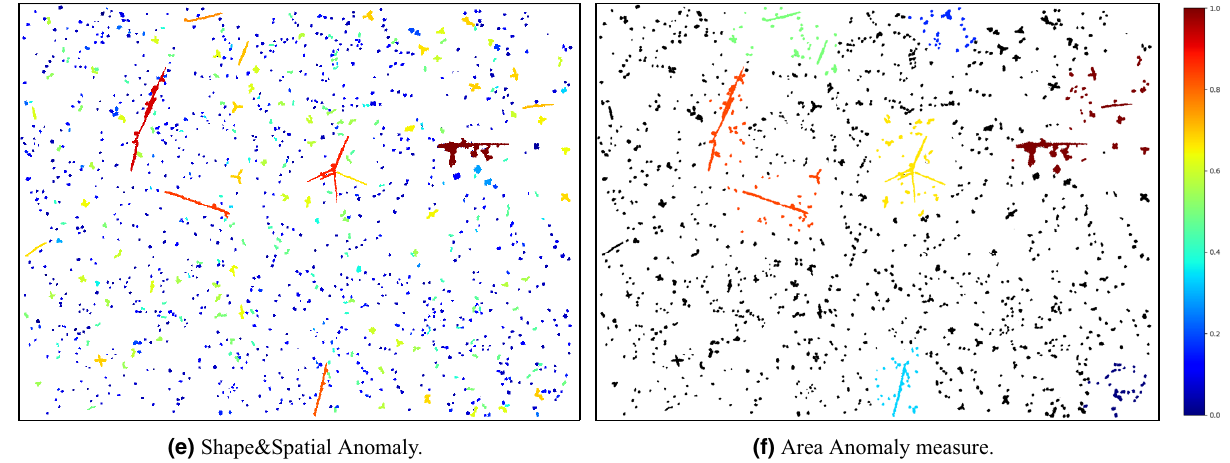
Figure 16. Anomaly detection